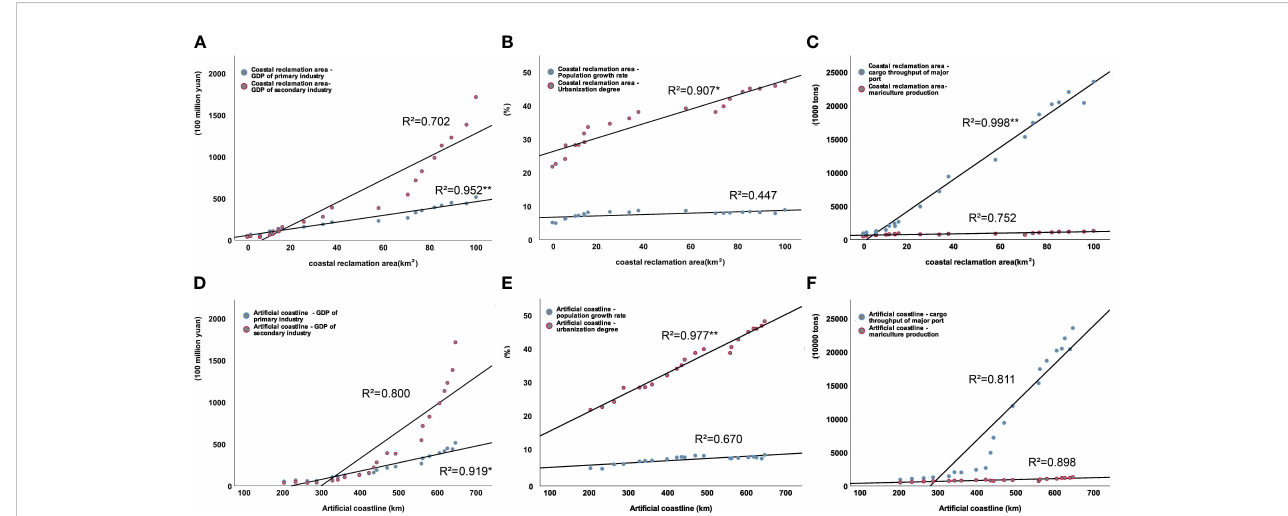
FIGURE 8 Linear regression between coastal reclamation and socio-economic factors, including economic development (A) , population growth (B) , and marine industry development (C) in coastal cities. (D – F) denotes the linear regression between coastline change and socio-economic